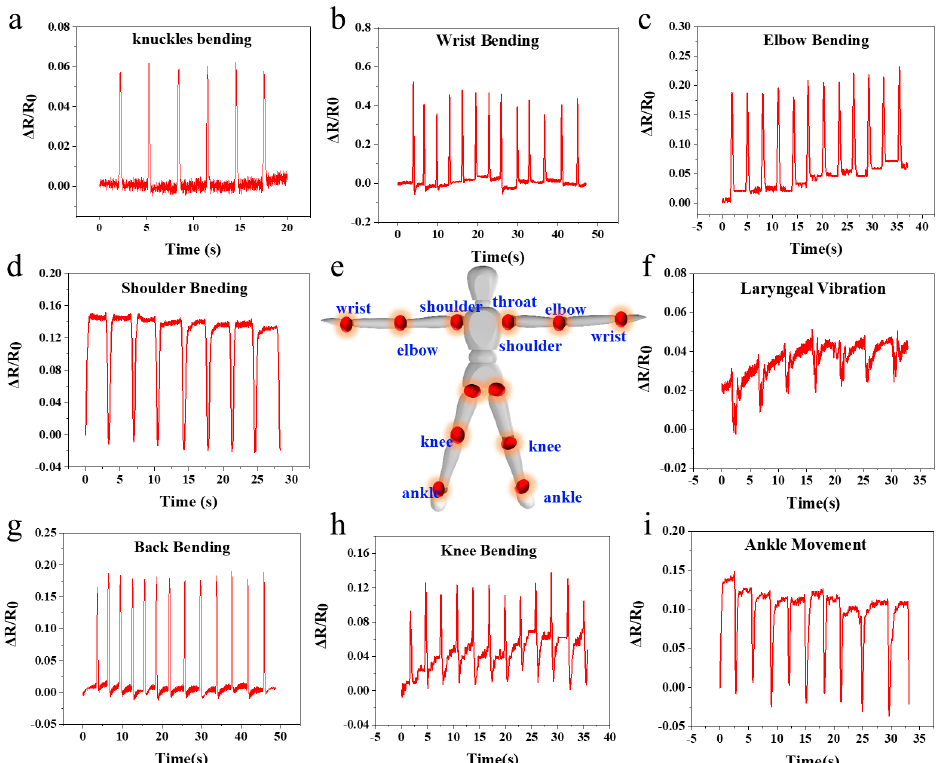
Figure 6. PVA-HEDP hydrogel sensor for human joint motion monitoring. ( a ) Knuckles bending, ( b ) wrist bending, ( c ) elbow bending, ( d ) shoulder bending, ( e ) schematic diagram of the movable joints in the human body, ( f ) laryngeal vibration, ( g ) back bending, ( h ) knee movement, ( i ) ankle movement.